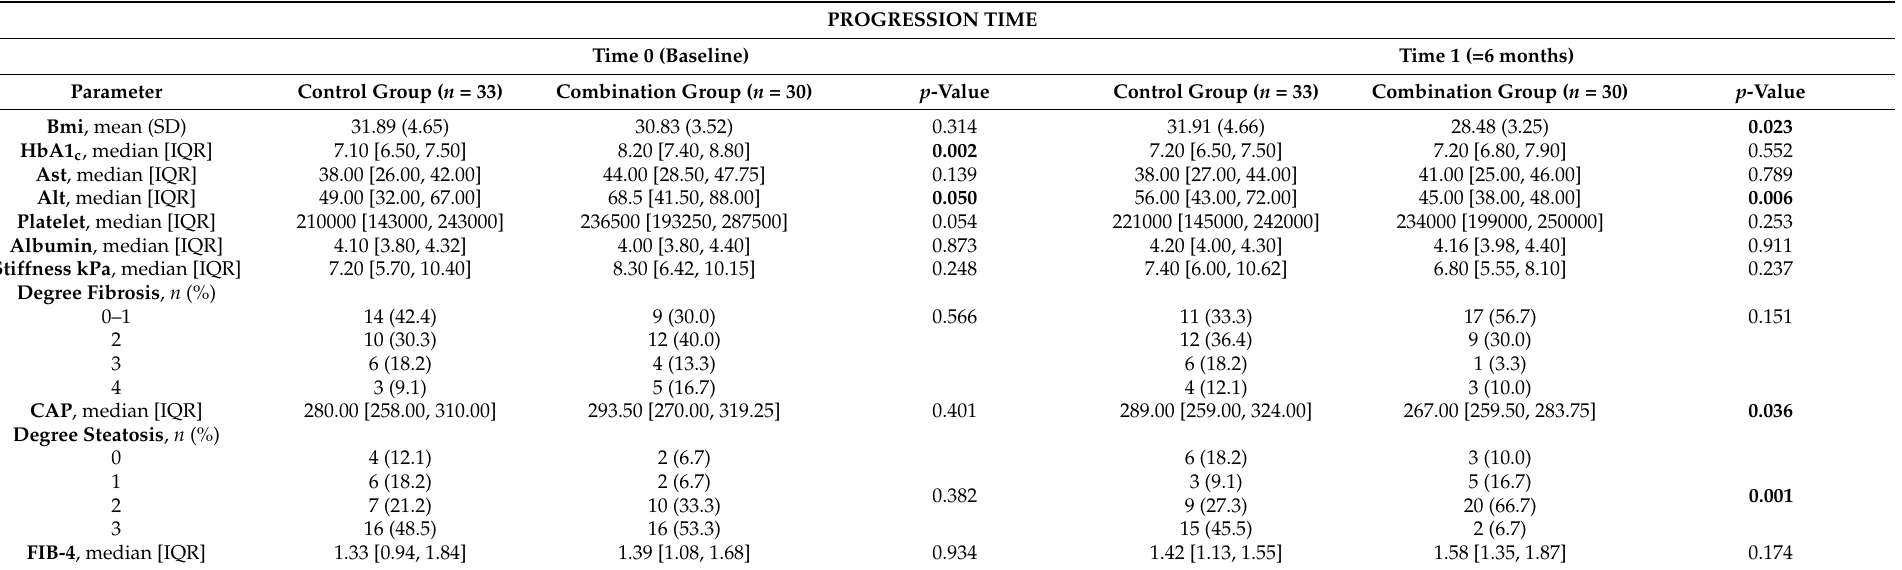
Table 2. Comparison of baseline and follow-up clinical, anthropometric, and laboratory data of the study